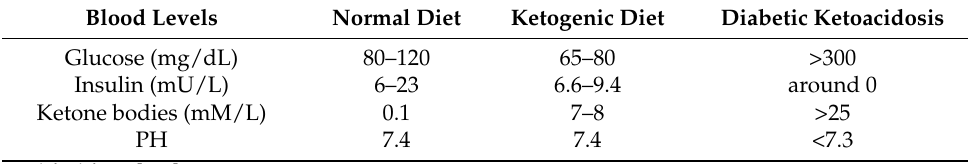
Table 4. Blood levels in normal diet, the ketogenic diet and diabetic ketoacidosis. Blood Levels Normal Diet Ketogenic Diet Diabetic Ketoacidosis Glucose